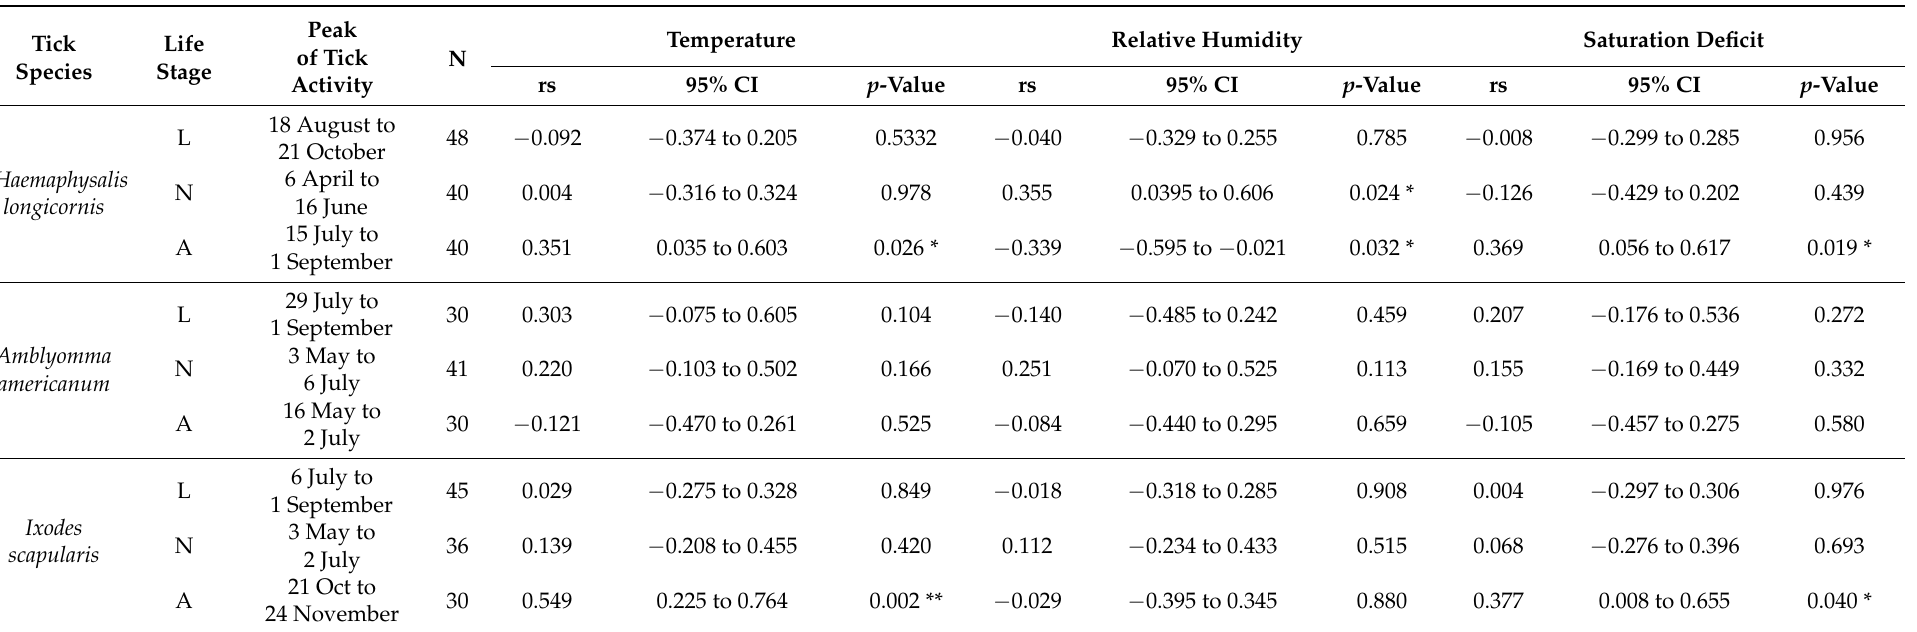
Table 3. Spearman rank (rs coefficient) correlations between the relative abundance of tick activity peaks and environmental variables. Life stages: larvae